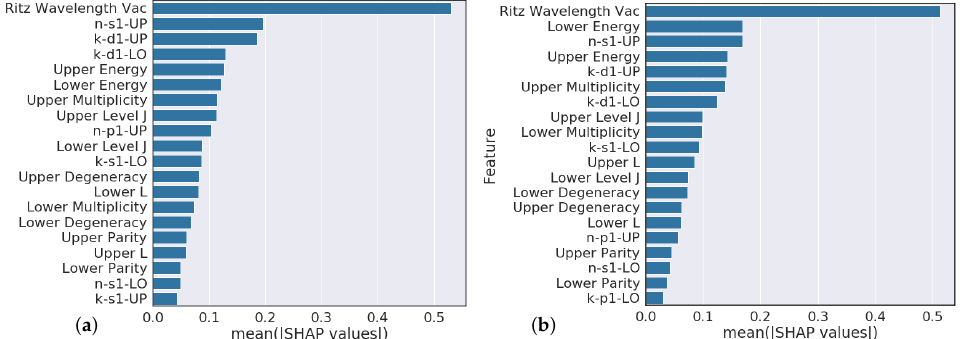
Figure 10. SHAP feature importance results for subsets of transitions for low-performing models (molybdenum, titanium, vanadium, iron, and chromium) ( a ) Top 10% of transition predictions; ( b ) Bottom 10% of transition predictions. The configuration parameter labels are in the format {n,k}-L#- {UP,LO}, where n and k denote if the feature is principle quantum number (n) or occupation number (k), L is the orbital angular momentum with the indexed (#) occurrence in the total configuration, and UP/LO associates it with the upper or lower energy level in a